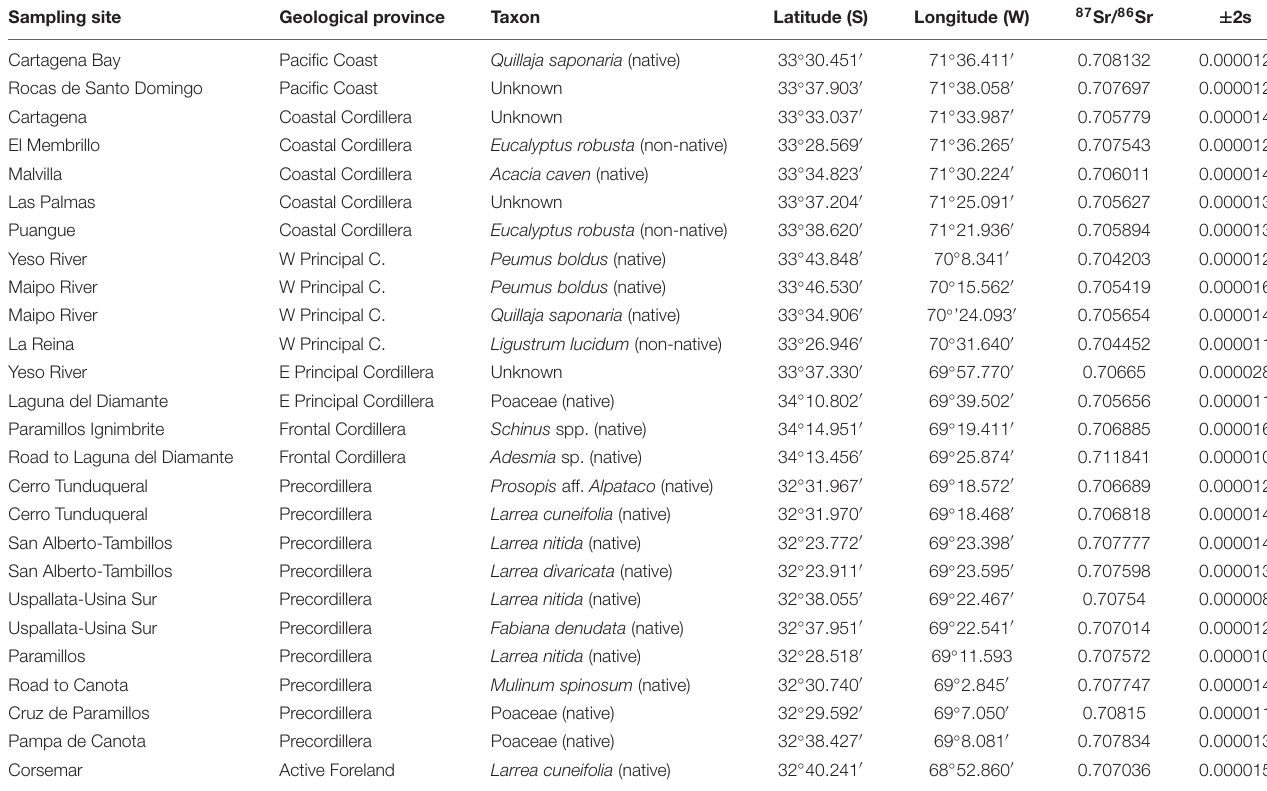
TABLE 2 | 87 Sr/ 86 Sr results for plant samples from the southern Andes of Argentina and Chile (source: this paper). Sampling